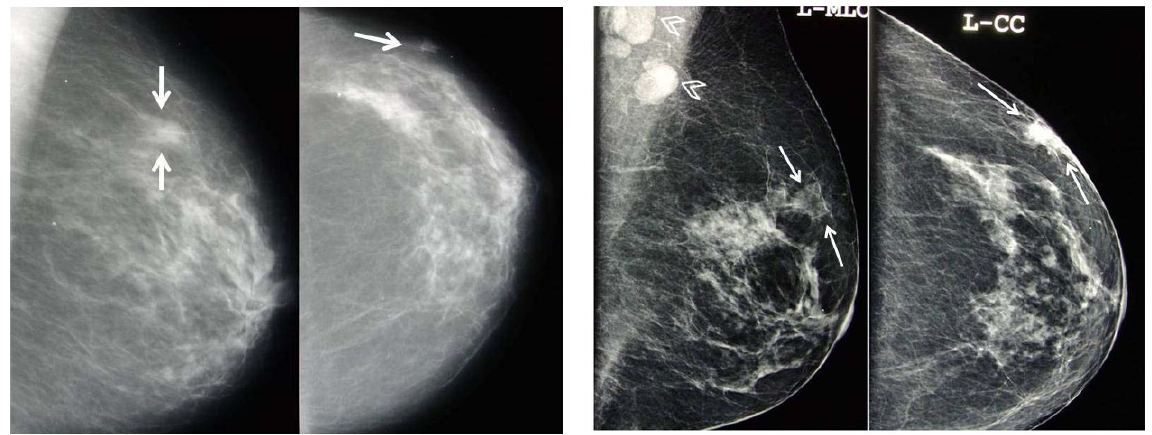
Figure 1b. The aforementioned area appears larger (arrows) compared to the previous mammography suggesting an infiltrative process, probably an infiltrating carcinoma. Multiple , enlarged axillary lymph nodes are present (open